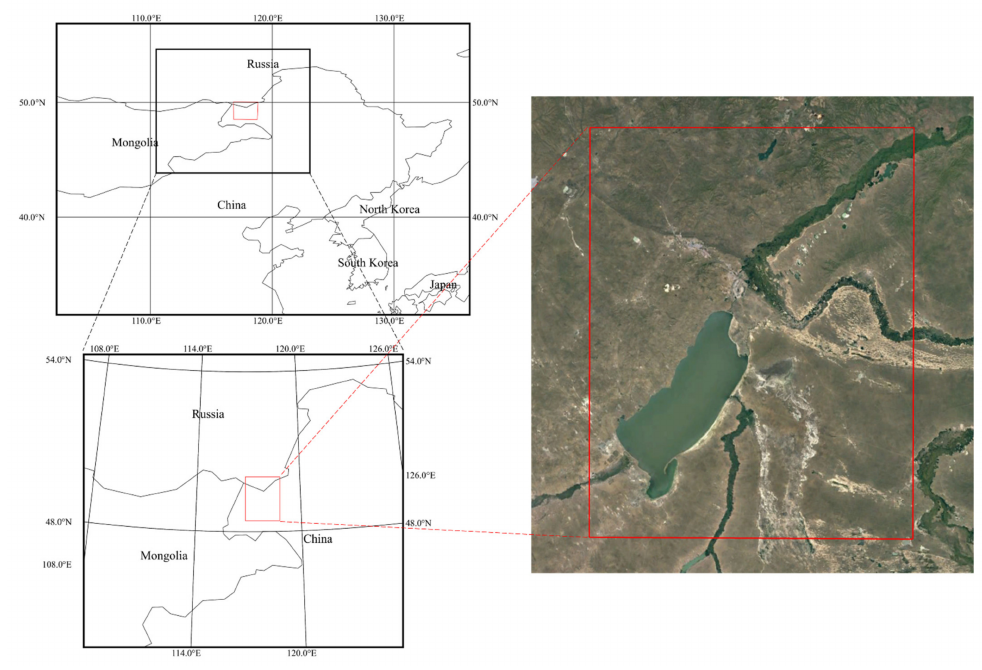
Figure 2. Location of the study